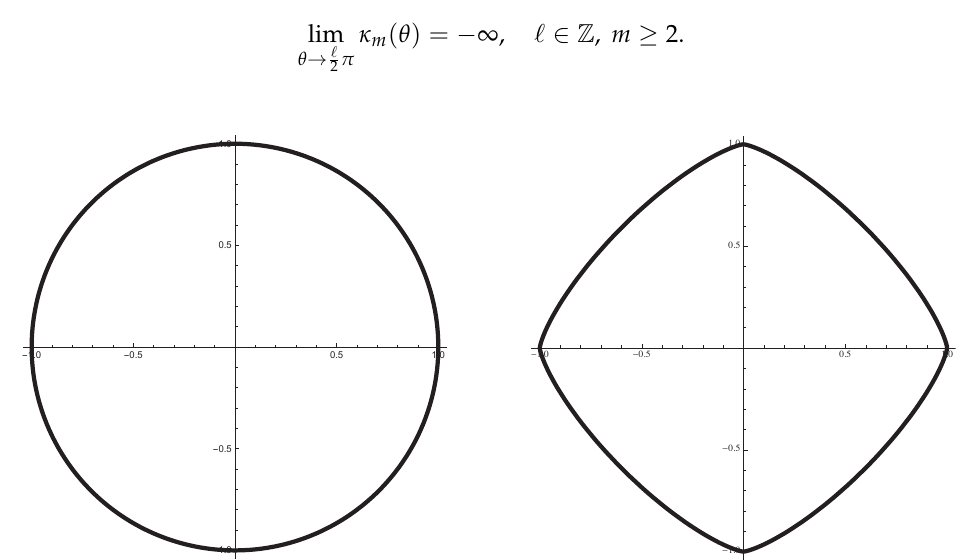
Figure 1. On the left, W γ